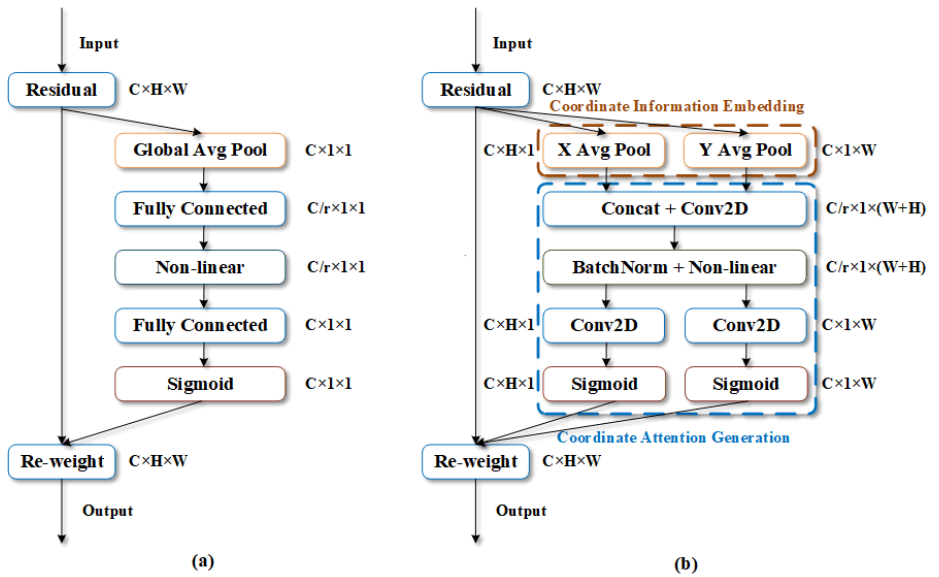
Figure 2. Structure of attention mechanism: ( a ) SENet; ( b )